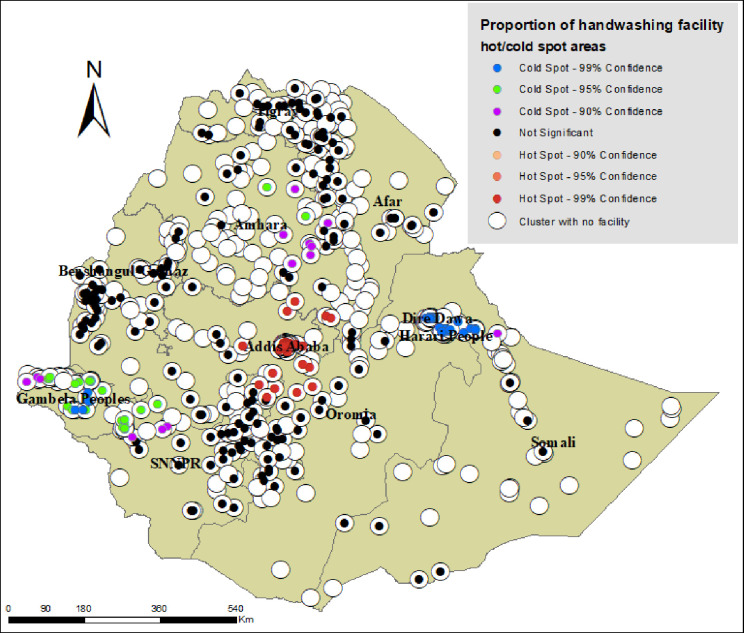
Map portraying hot spot and cold spot areas of basic handwashing facilities in Ethiopia, based on the 2016 EDHS.